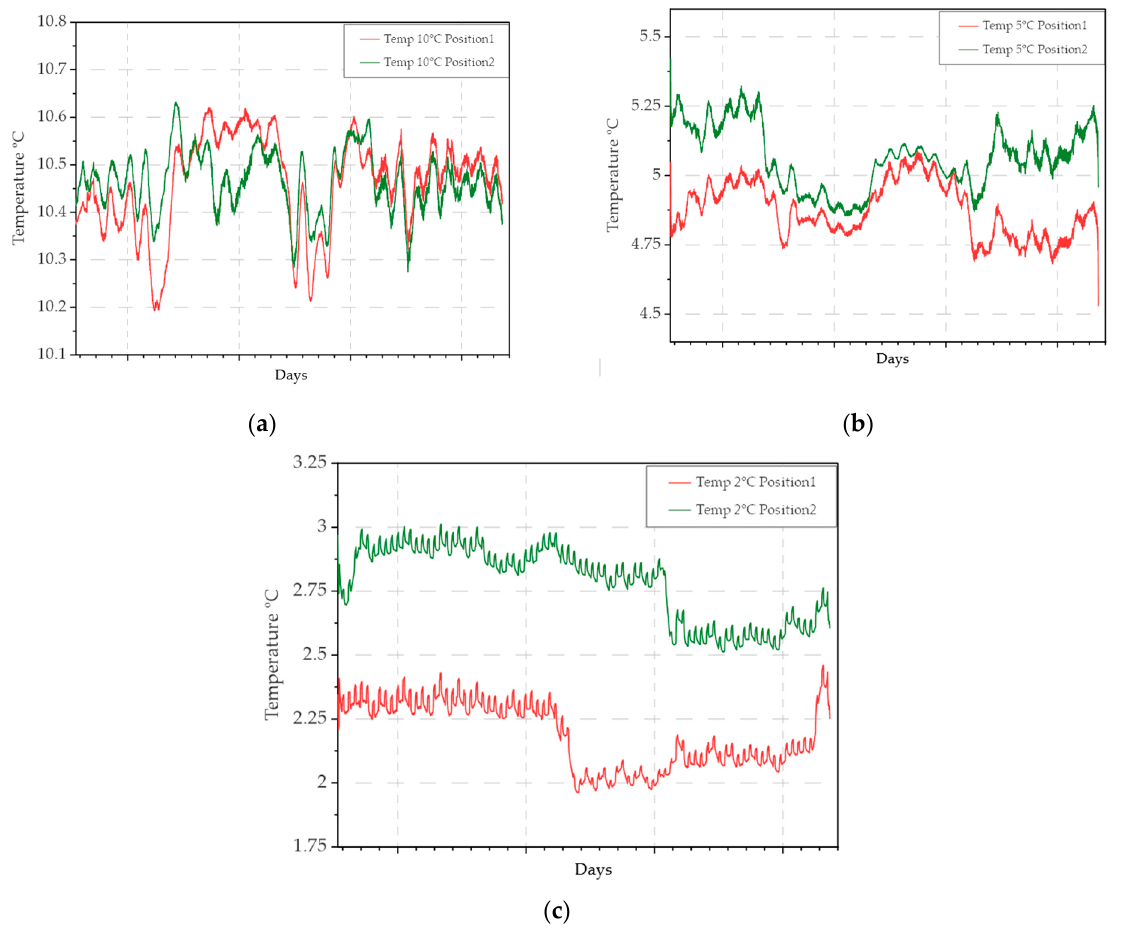
Figure 16. Evolution of the temperature between the two node locations at different temperatures: ( a ) 10 °C; ( b ) 5 °C; ( c ) 2 °C.